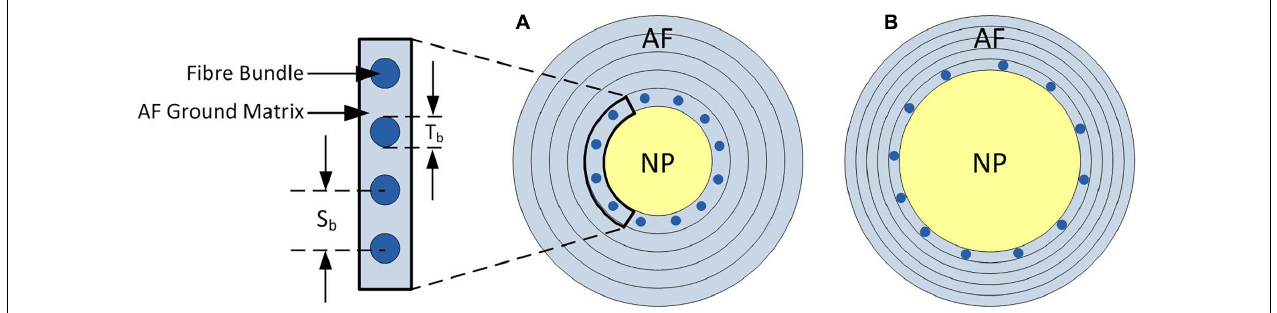
FIGURE 3 | Schematic of axial cross-section of the IVD demonstrating the change in fibre bundle spacing required to allow a fair comparison between models when adjusting the NP:AF ratio. (A) Shows a baseline NP:AF ratio with a cut out showing the fibre bundle thickness (Tb), and interbundle spacing (Sb), (B) shows an increased NP:AF ratio with larger interbundle spacing. Bundles are only shown in the inner most lamella in both schematics, with a total of 12 bundles shown in both (A,B) , although larger interbundle spacing in (B) resulting in the same fibre bundle volume as that shown in (A) . Note these schematics are not to scale.